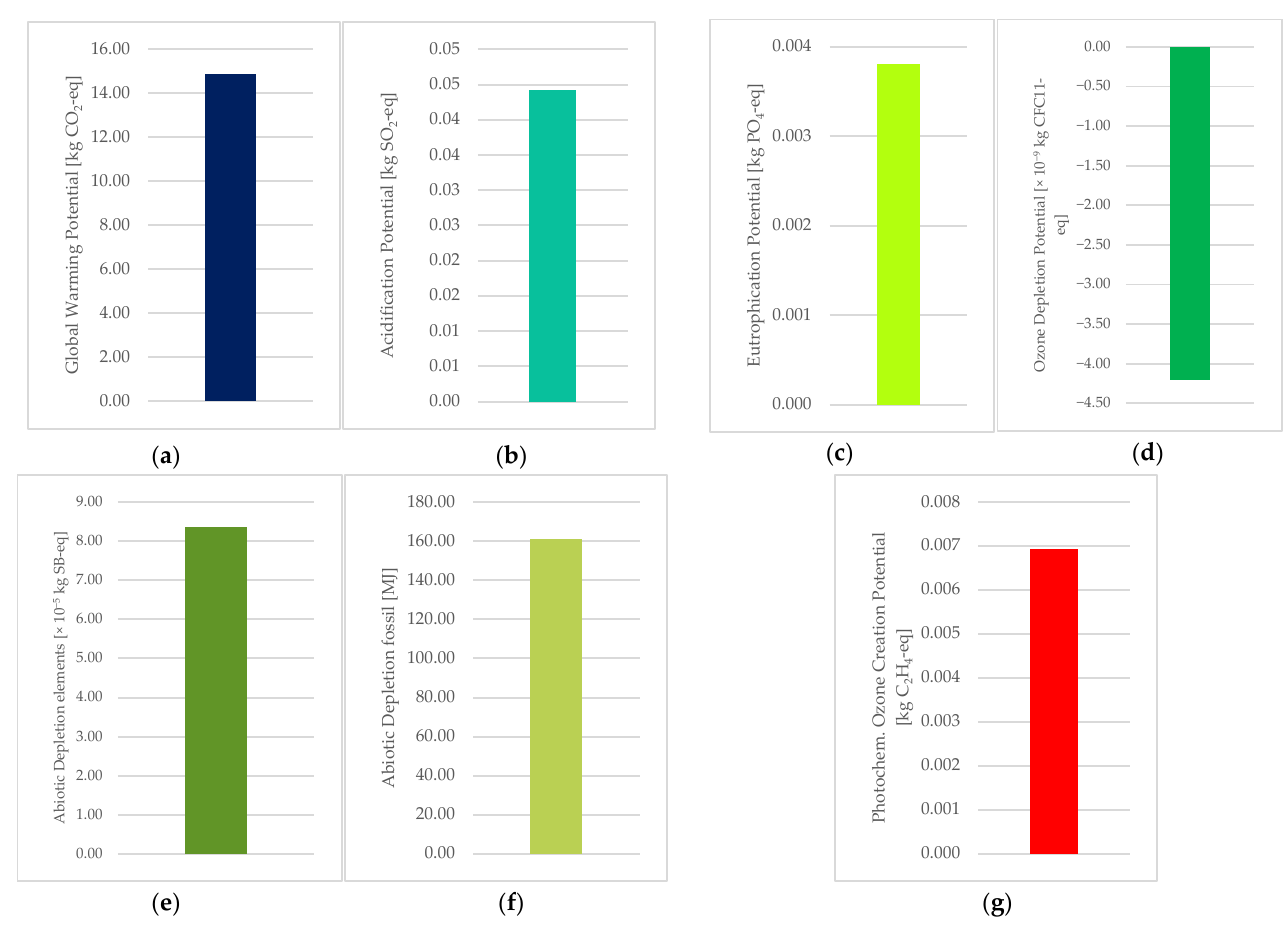
Figure 5. Outputs from GaBi showing the environmental impacts of organic steel coil production for 1 m 2 of roof: ( a ) GWP; ( b ) AP; ( c ) EP; ( d ) ODP; ( e ) ADP elements; ( f ) ADP fossil; ( g ) POCP. Table 2. Comparison of the life cycle impacts of the imported and locally sourced organic coated